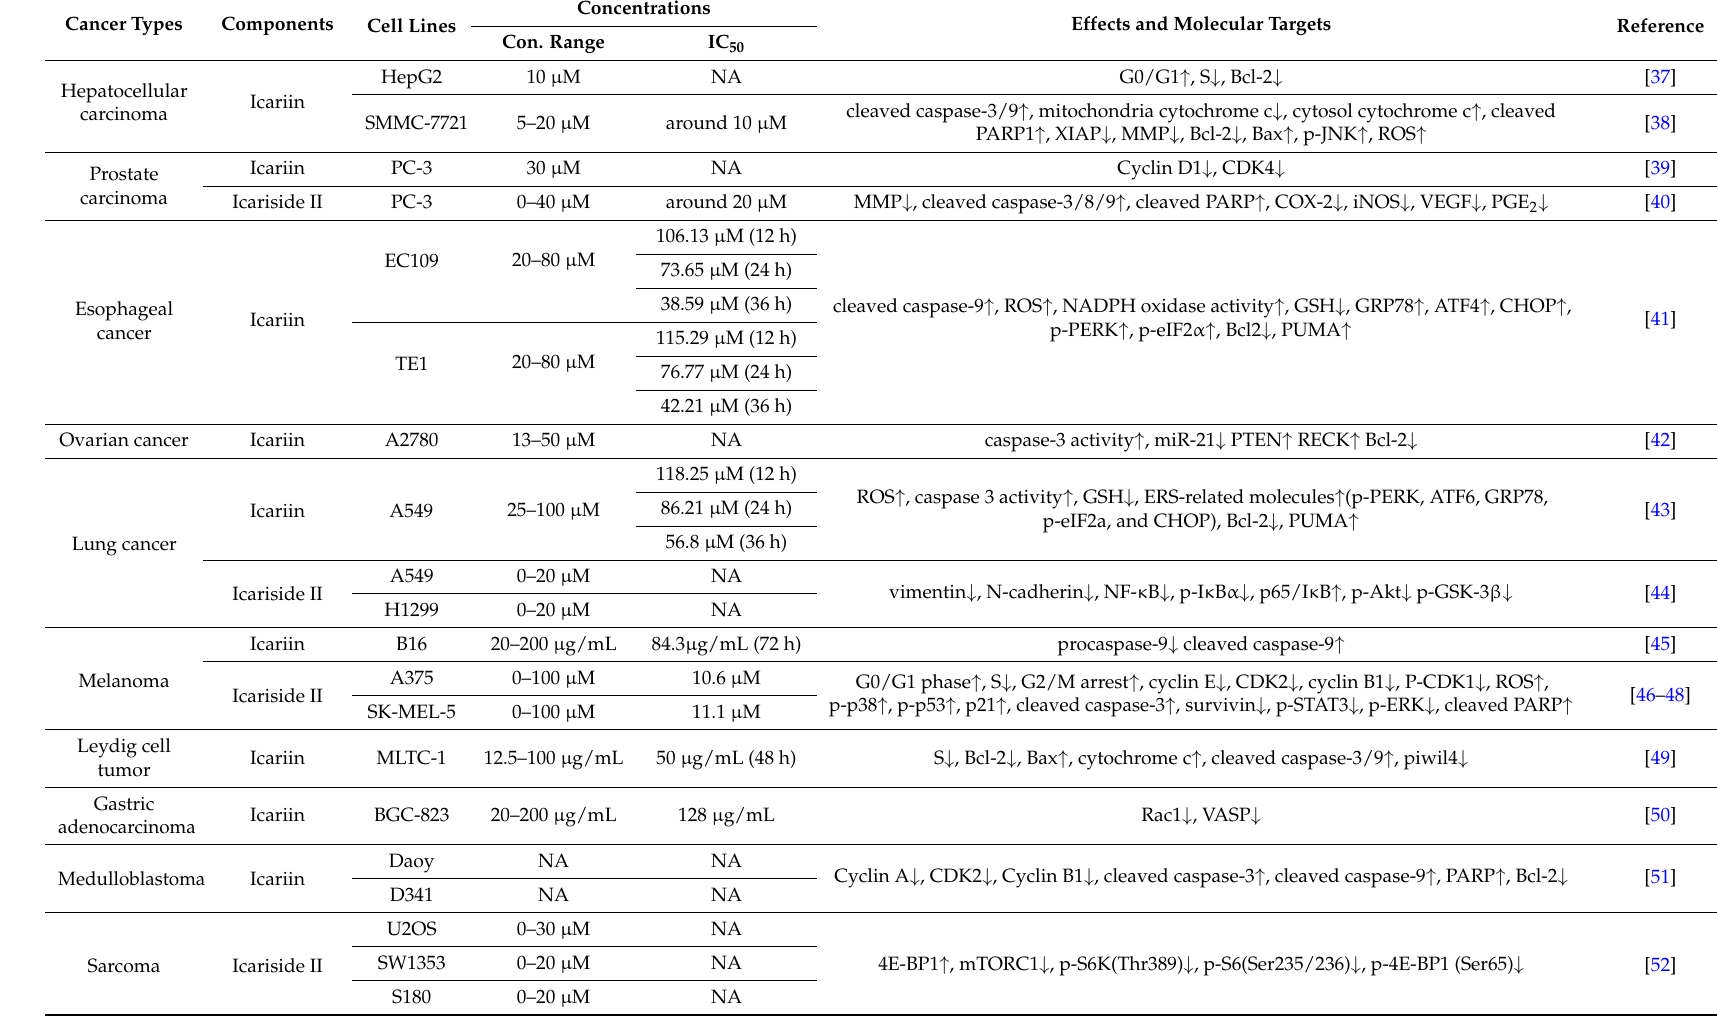
Table 1. Effects and molecular targets of icariin and icariside II on different cancer cell